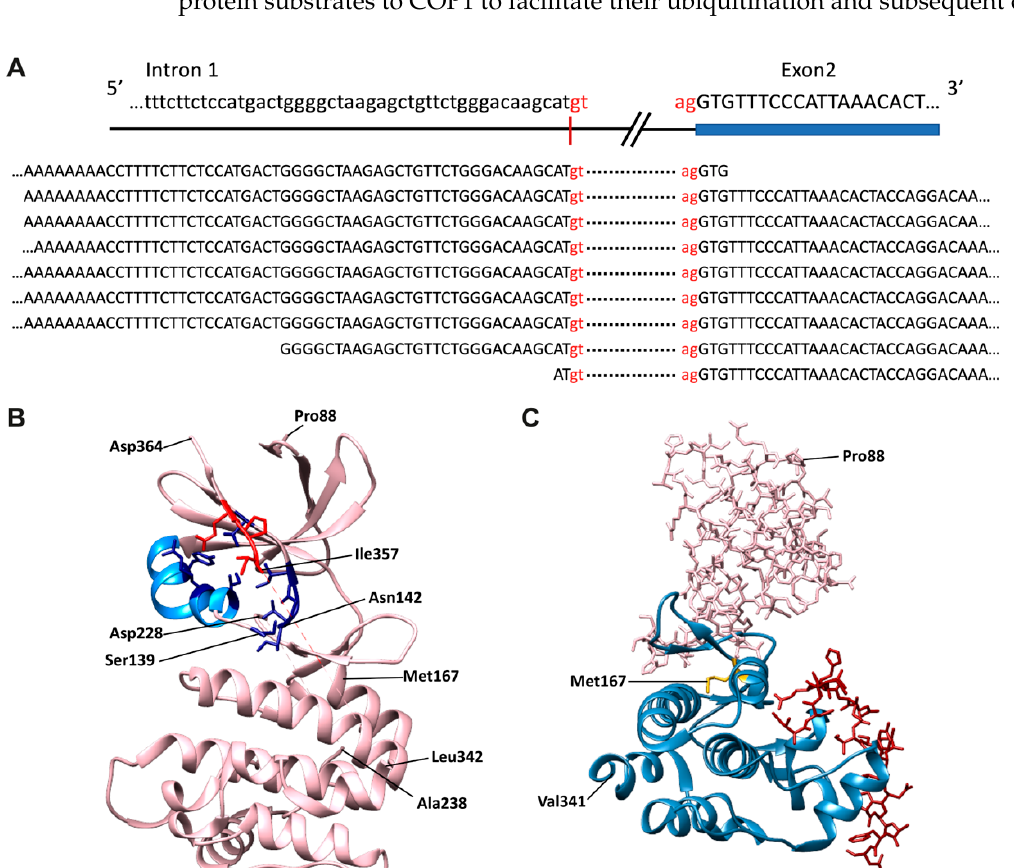
Figure 4. Analysis of putative TRIB1 -203 gene-product. ( A ) TRIB1 -203 transcripts detected in whole-cell total RNA extracted from human diencephalon, frontal cortex, occipital and parietal lobe samples. RNA-seq reads, downloaded from ENCODE, aligned against reference genome hg38. Nine TRIB1 -203 transcripts were detected in these samples compared to 263 reads crossing the canonical exon 1 and 2 junctions. Nucleotides “gt” and “ag” define the splicing junction represented by the dotted line and are not present in the read sequence. ( B ) Schematic of structure for amino acids 84 − 365 of substrate-free TRIB1 (5CEM) [52]. Selected residues in α C-helix (depicted in blue) and β 4-strand forming the COP1-binding peptide (red) binding pocket are depicted as sticks. Pink dotted lines: no electron density for amino acids 229 − 237 and 343 − 356. ( C ) Structure for amino acids 53 − 75 of C/EBP α (brown) bound to N- and C-terminally truncated TRIB1 [53]. Blue ribbons represent structures predicted to be encoded by the TRIB1 -203 transcript.